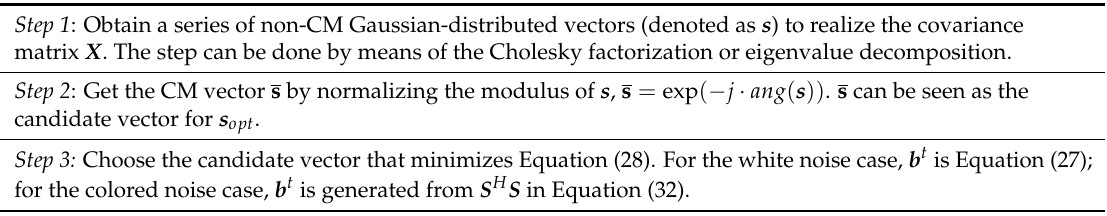
Table 1. Gaussian randomization method for CM arbitrary-phase waveform design.